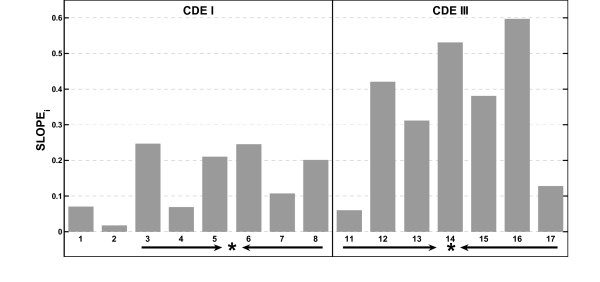
Symmetric position specific regression line slope magnitudes for CDEI & CDEIII sites. A bar chart of the position specific regression lineslopes from plots of loge (chrom. Loss rates) vs. unsignedPD change for both CDEI and CDEIII sites. Symmetry centers for both sites are marked with an asterisk and palindromic regions with bolded arrows. In the case of CDEI, symmetry is between positions 5 and 6. For CDEIII, symmetry centers on position 14, the central conserved cytosine.